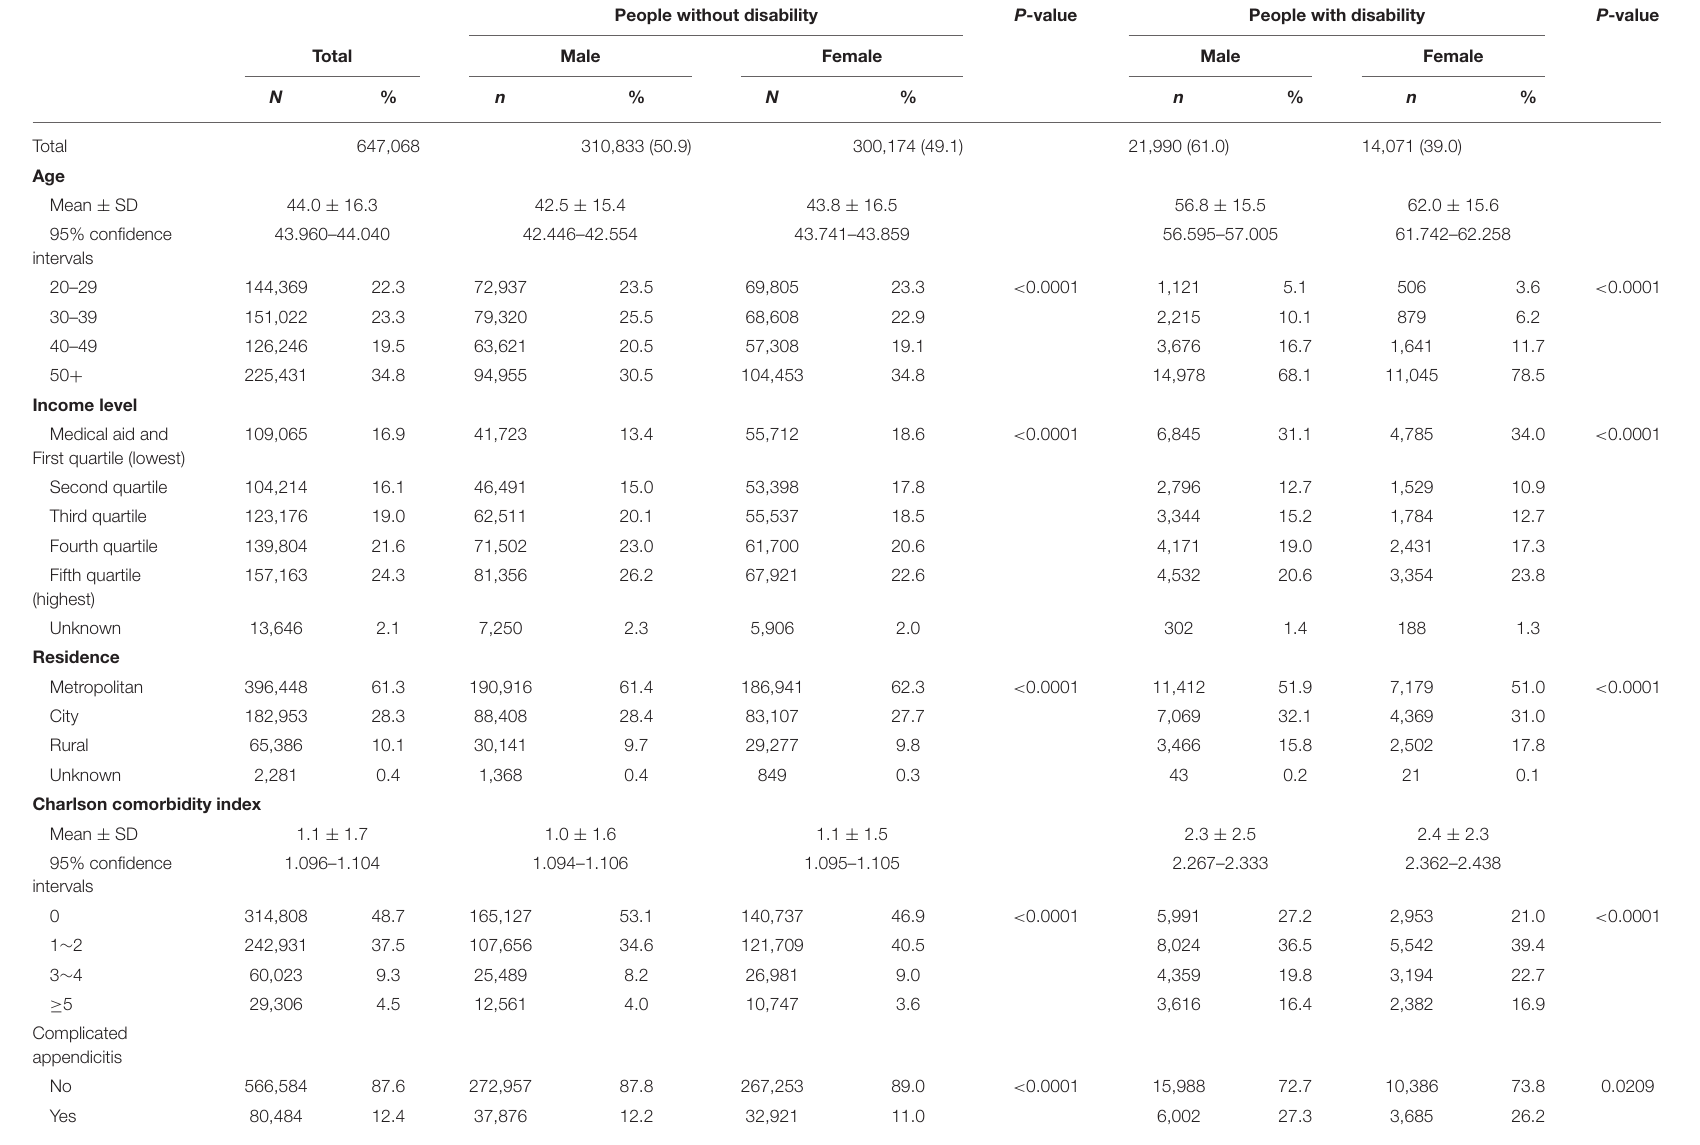
TABLE 1 | Baseline characteristics of study population in South Korea during 2008–2017 according to disability status and sex. People without disability P -value People with disability P